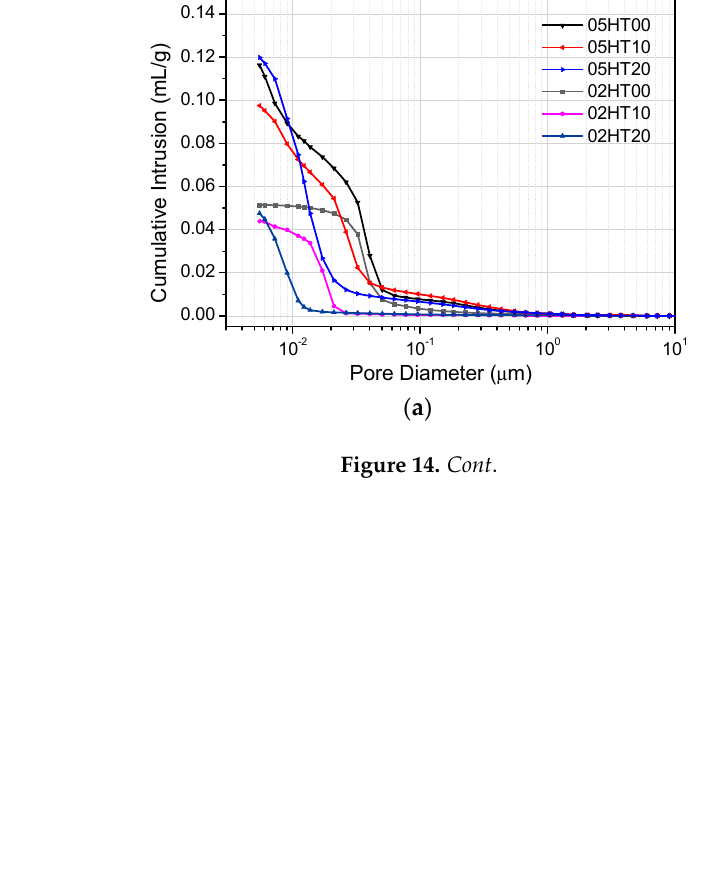
Figure 13. ATR-FTIR spectra for all the samples at the age of 28 days when ( a ) w/b = 0.5 and ( b ) w/b = 0.2.